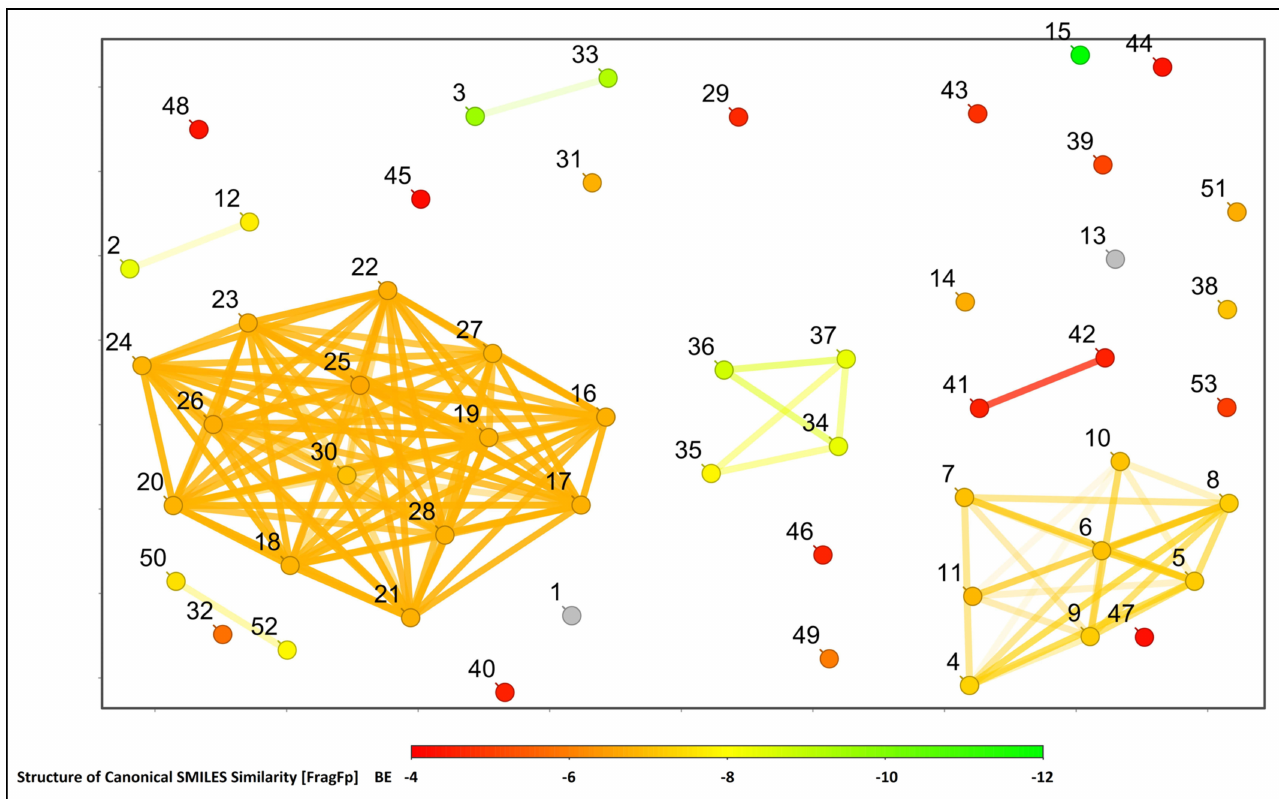
Figure 6. The image represents the structural activity relationship of 52 molecules and a standard drug undertaken during the study. Lines between dots represent structurally similar molecules, and the number on each dot represents the name of the molecule, as listed in Table